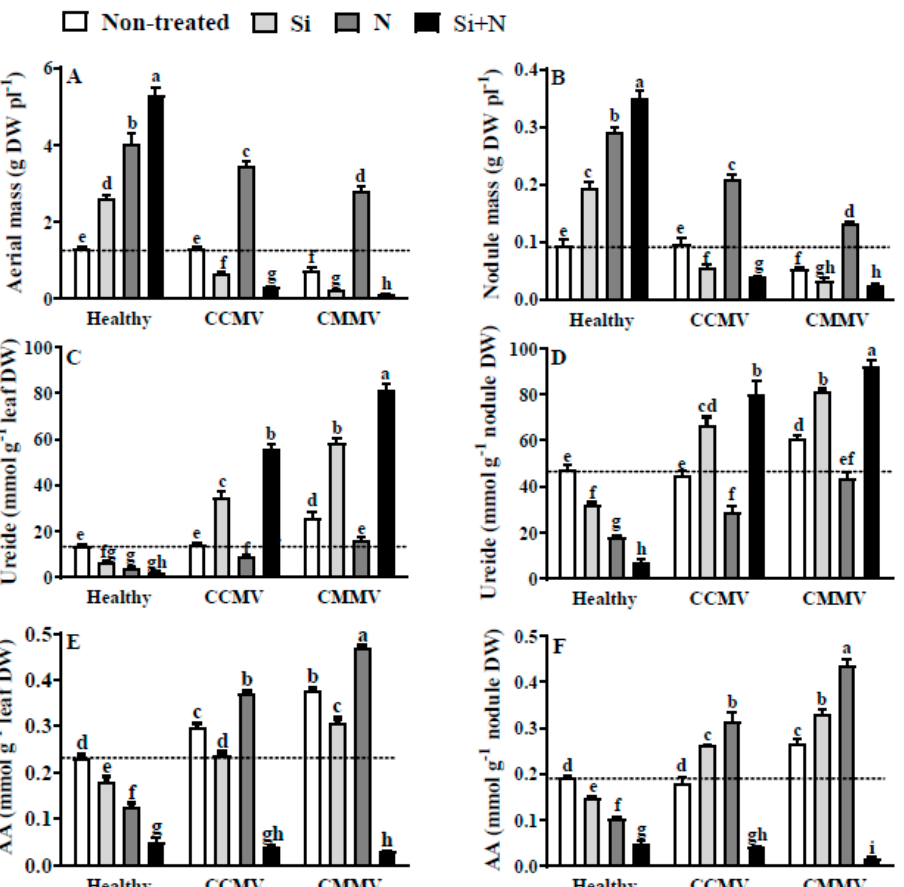
Figure 2. Effects of 2 mM silicic acid (Si), 10 mM KNO 3 (N) and the combination of Si + N on the aerial mass ( A ), nodule mass ( B ), ureide content in the leaves ( C ) and nodules ( D ), and amino acids (AA) content in the leaves ( E ) and nodules ( F ) of healthy and Cowpea chlorotic mottle virus (CCMV) or Cowpea mild mottle virus (CMMV)-infected 30-days old yardlong bean ( V. unguiculata subsp. sesquipedalis ). Dotted line serves as reference to value of healthy non-treated control. Means of six replicates (±SE) in bars labeled with the same letter(s) are not significantly different (LSD, p < 0.05).